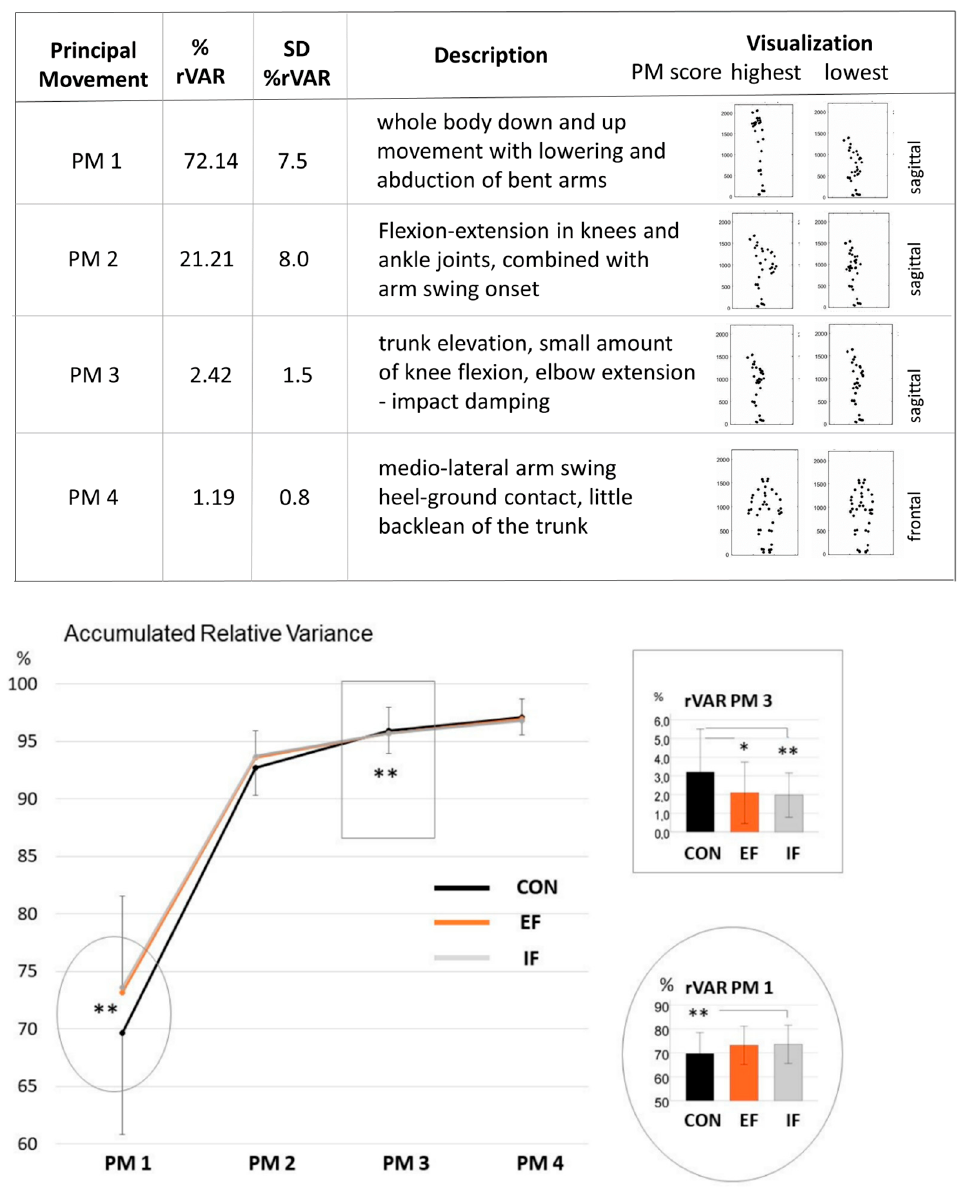
Figure 2. The large panel shows the accumulated subject-specific relative variance for the first four principal movements (PMs) ( left ) in the CON (without instruction), IF (internal focus), and EF (external focus) conditions over all trials. The small panels show the subject-specific variance for the first PM ( round panel ) and third PM ( square panel ) (** p < 0.01, * p < 0.05).